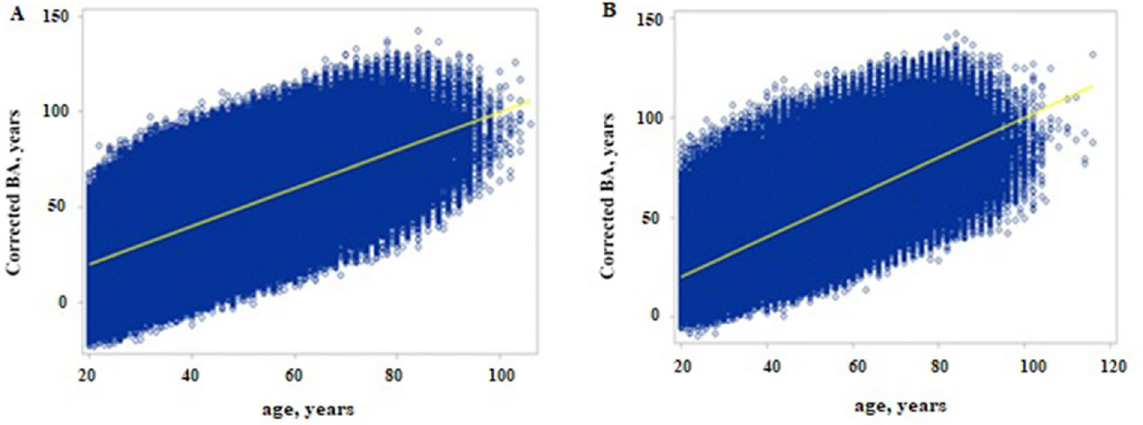
Figure 1. Relationship of MS BA in function of age for male ( A ), Female ( B ).